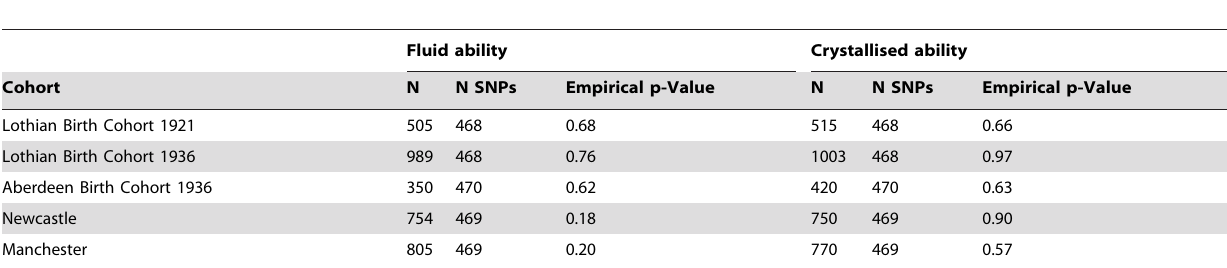
Table 1. Association between fluid and crystallised ability and the G protein gene set for each of the five CAGES cohorts.